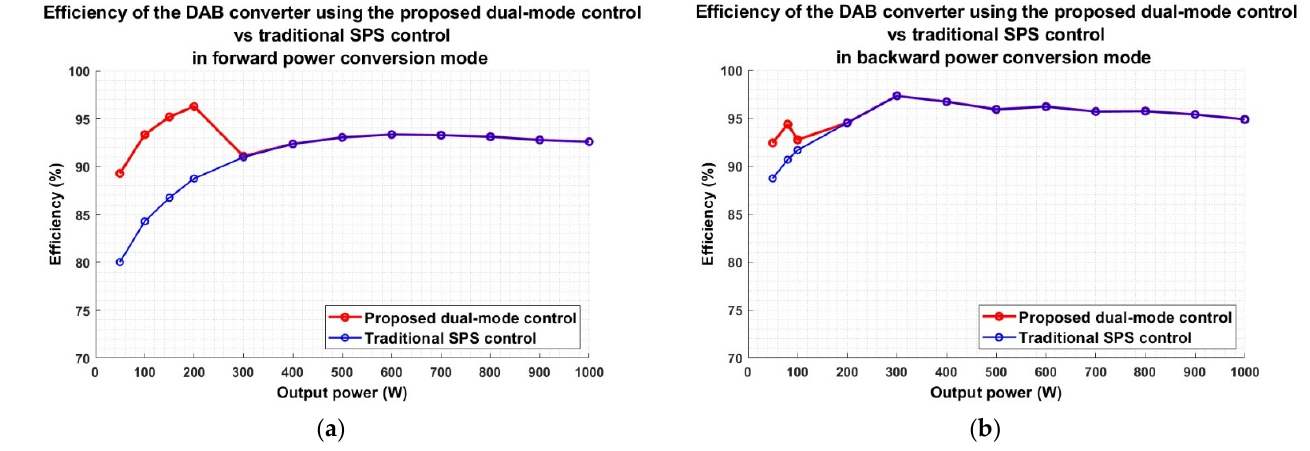
Figure 24. Comparison of the efficiency of the DAB converter using the proposed dual-mode control strategy and a DAB converter using the traditional SPS control strategy: ( a ) forward power conversion mode; ( b ) backward power conversion mode. Table 4. Efficiency comparison of the DAB converter with different control strategies in forward power conversion.